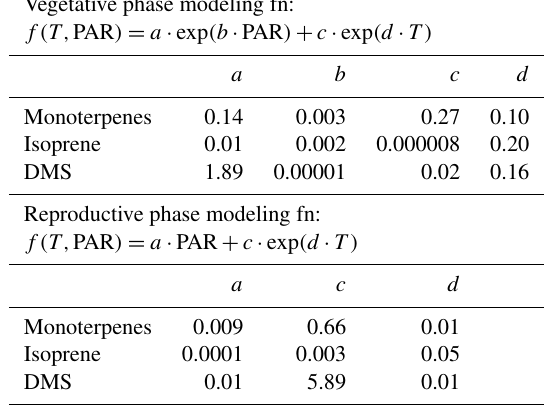
Table 3. Bivariate fit functions and their coefficients for BVOC emission flux parameterizations as a function of PAR and tempera- ture in both the reproductive and vegetative phases of